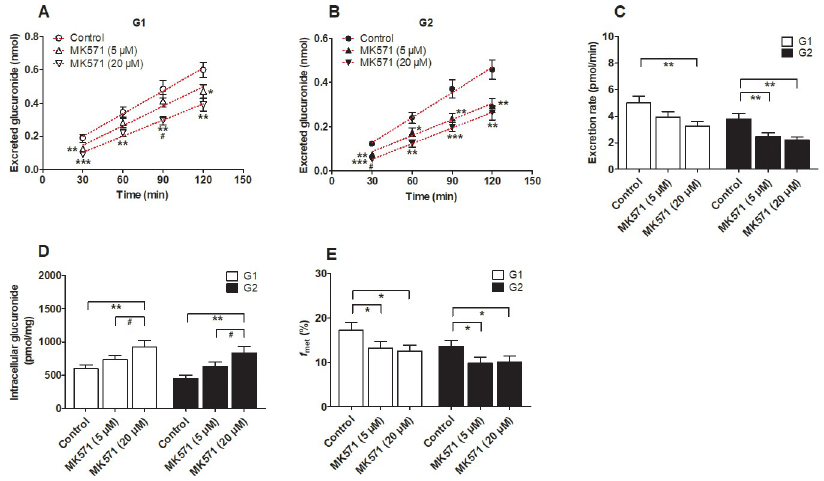
Fig 6. Transporter inhibitor MK571 inhibited the generation and excretion of demethoxycurcumin- O - glucuronides in HeLa1A1 cells. (A) MK571 (5 and 20 μ M) inhibited the excretion of demethoxycurcumin- O - glucuronides (G1) in extracellular medium; (B) Inhibitory effects of MK571 (5 and 20 μ M) on the excretion of demethoxycurcumin- O -glucuronides (G2) in extracellular solution; (C) MK571 (5 and 20 μ M) decreased the efflux excretion rates of G1 and G2; (D) MK571 (5 and 20 μ M) evaluated the intracellular levels of G1 and G2; (E) MK571 (5 and 20 μ M) reduced the overall formation ( f met ) of G1 and G2 in HeLa1A1 cell; The concentration of demethoxycurcumin was 4 μ M. All experiments were performed in triplicate (n = 3). Data were presented as mean ± SD (n = 3). � , # p < 0.05, �� , ## p < 0.01 and ��� , ### p < 0.001 compared with that of control group of G1 or G2,